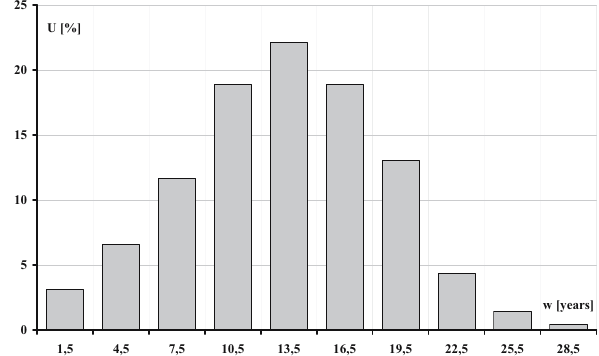
Figure 4: Dependence of the share of vehicles with faults among vehicles in a given mileage range for vehicles purchased domesti - cally ( black line ) and imported ( red line ) .